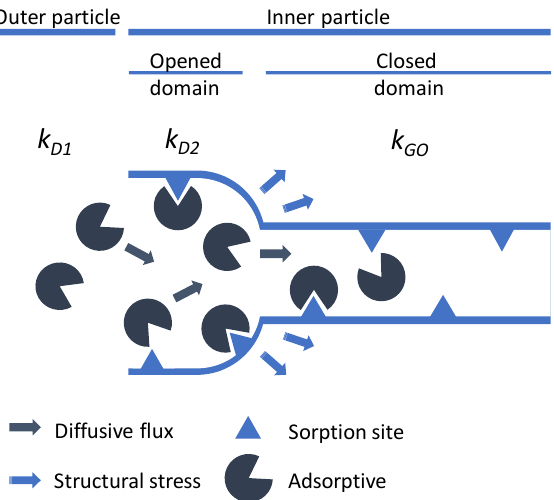
Figure 6. Schematic representation of the governing processes during adsorption of n -butane on 1 and their respective rate constants.